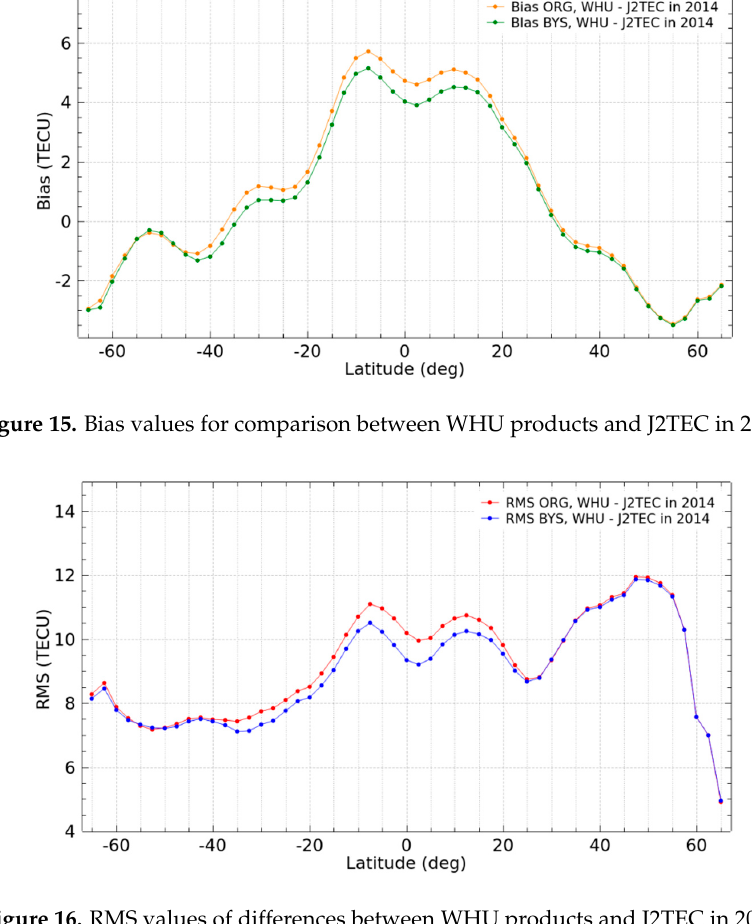
Figure 16. RMS values of differences between WHU products and J2TEC in 2014.